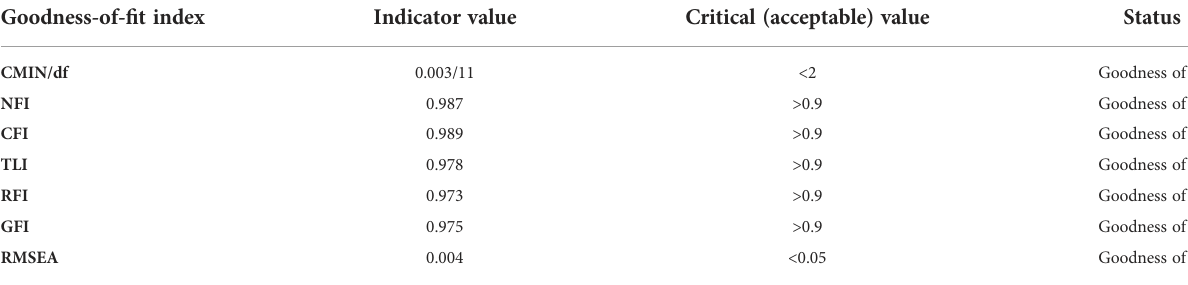
TABLE 6 Goodness-of- fi t measures for model evaluation.